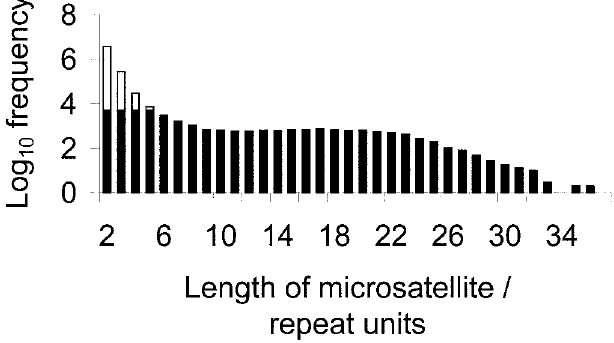
Figure 1. Frequency Distribution of Isolated, Pure (AC) n Microsatellite Lengths (in Repeat Units) in the Human Genome Black shading indicates numbers of microsatellites used for analyses in this study. DOI: 10.1371/journal.pbio.0020199.g001